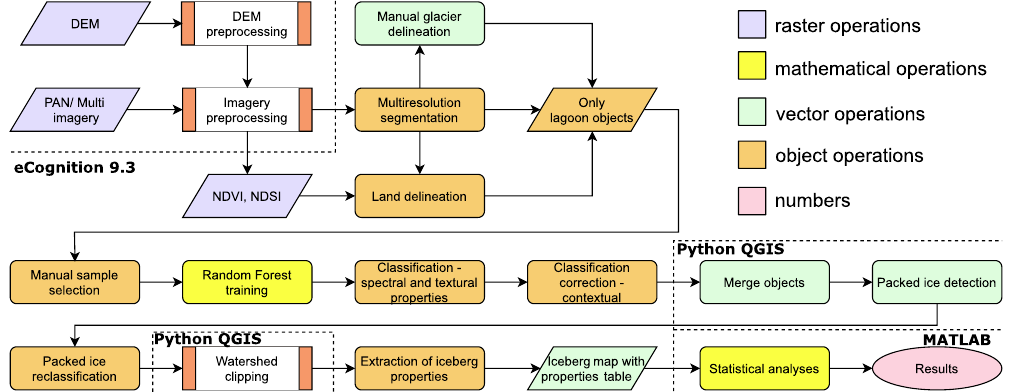
Figure 5. Entire procedure of iceberg inventory creation. Steps enclosed in white-brown rectangular boxes are shown in detail on other